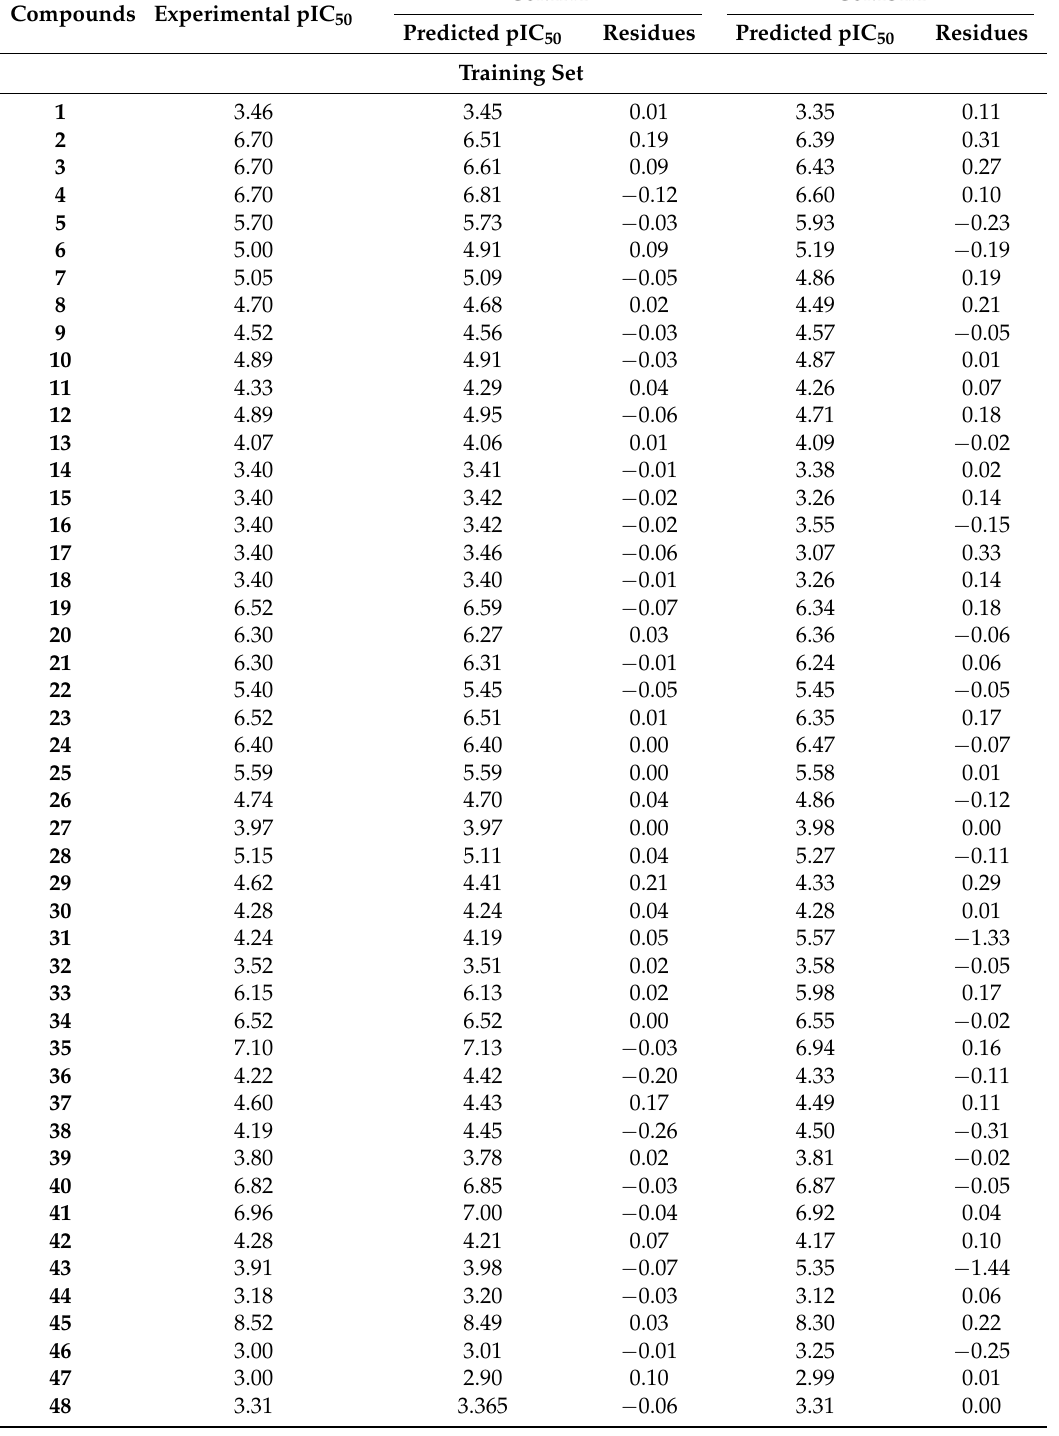
Table 2. Comparison of the experimental pIC 50 values, predicted pIC 50 values and residual values of the 97 compounds for CoMFA and CoMSIA models derived from the ligand-based alignment